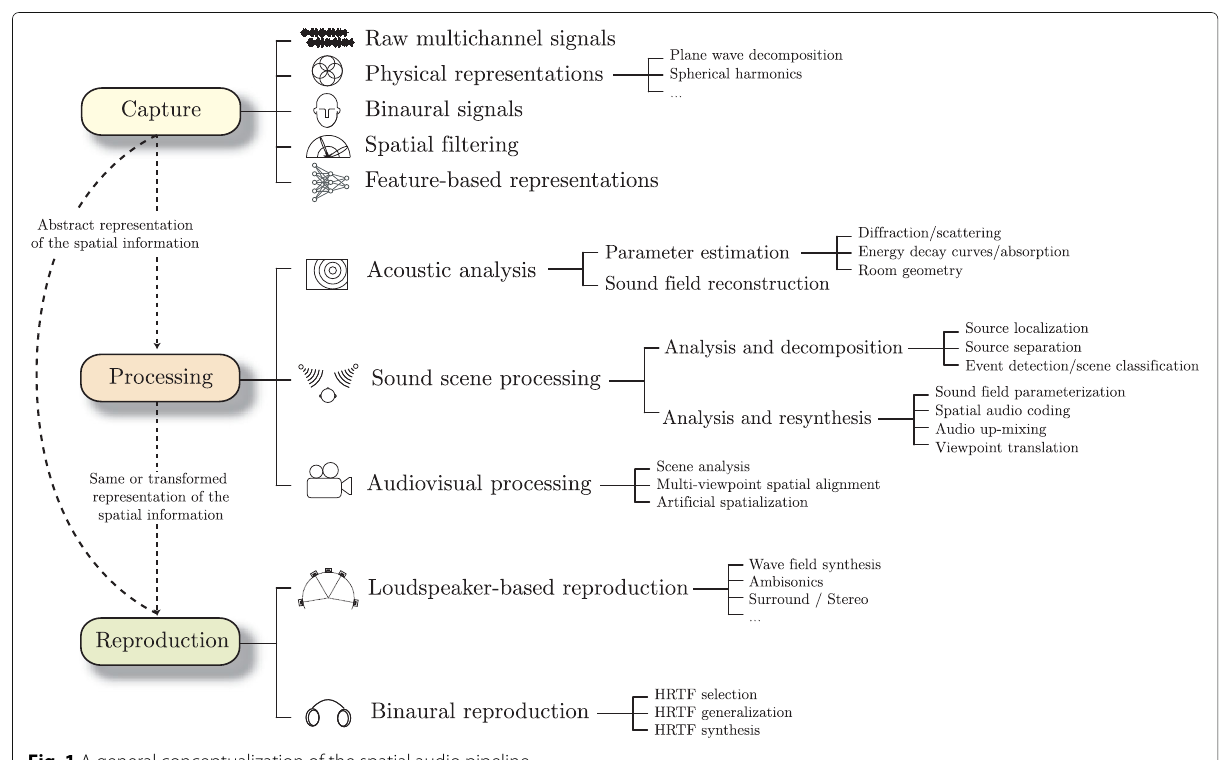
an abstract representation of the physical structure of the captured sound field. Examples for this are the plane wave decomposition or the spherical harmonic decomposition. The coefficients of the decomposition serve as the out- put format of the capture stage. The output of the capture stage may be piped directly to the reproduction stage, or, it may be